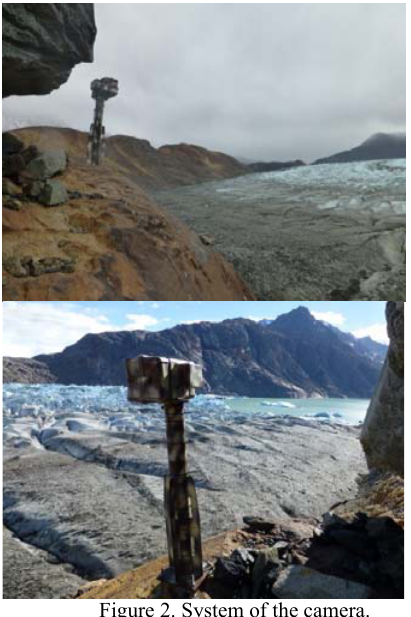
Figure 2. System of the